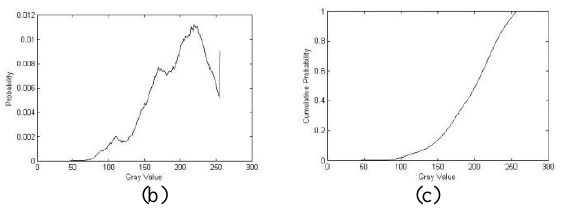
Figure 2. Statistics of gray value of cloudy images. (a) Parts of collected cloud image from Landsat-8. (b) Histogram of the cloud pixels. (c) Corresponding cumulative histogram of (b).